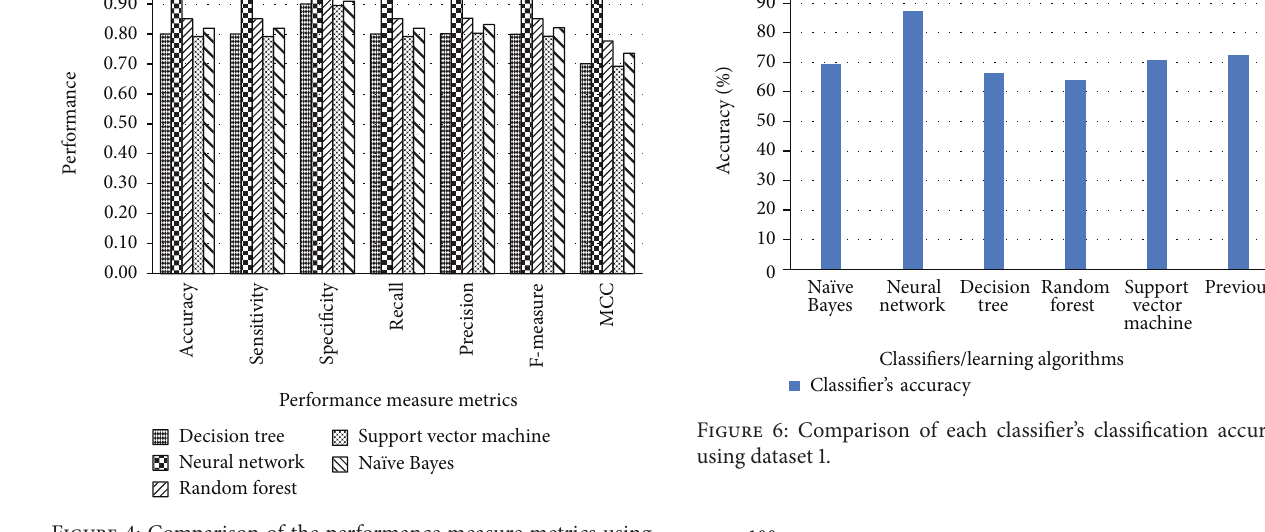
Figure 4: Comparison of the performance measure metrics using dataset 2.